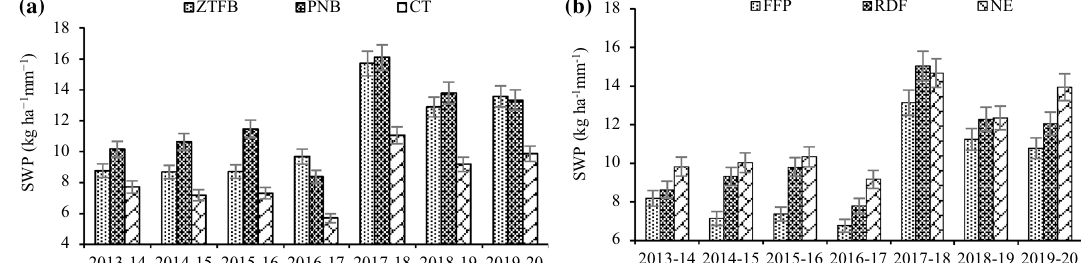
Figure 4. Seven years’ trends of SWP ( a , b ) in the CA-based CEP and nutrient management under the maize– chickpea rotation. The vertical bars indicate the LSD at p = Farm economics. The 7 years’ mean data indicated that the CT (US$ 639.9 ha −1 ) was the most expensive CEP, which was 15.3% and 16.9% costlier than the PNB (US$ 541.7 ha −1 ) and ZTFB (US$ 531.6 ha −1 ), respec- tively. Likewise, the RDF (US$ 582.7 ha −1 ) accounted for the highest cultivation cost, closely followed by the NE (US$ 576.7 ha −1 ), being 5% and 4.1% higher over the FFP (US$ 553.3 ha −1 ), respectively. In all the years, the PNB had the highest net returns, whereas, in 2016–17, the ZTFB accounted for the greater returns. However, the ZTFB and PNB did not differ for the system net returns, except during 2013–2014, 2016–2017, and 2018–2019. The PNB (US$ 1671.1 ha −1 ) and ZTFB (US$ 1565.9 ha −1 ) had generated 28.8% and 24% higher net returns than the CT (US$ 1189.8 ha −1 ), respectively. Similarly, the NE (US$ 1635.9 ha −1 ) and RDF (US$ 1528.4 ha −1 ) had 22.8% and 17.4% greater net returns than the FFP (US$ 1262.9 ha −1 ) (Table 3), respectively. Sustainable yield index (SYI). Among the CEP in maize, the PNB had the greater SYI, but being at par to the ZTFB, which was 15% and 13.2% greater than the CT. Further, SYI in maize was the highest under the NE, similar with RDF, being 29.1% and 25.6% greater than the FFP. In the case of chickpea, the SYI was highest under the PNB, which was 12.4% and 23.6% higher than the ZTFB and CT, respectively. The SYI in the NE and RDF were at par, being 8.9–12.8% greater than the FFP in chickpea (Table 1). System water productivity (SWP). During the first 3 years of the study, the PNB (10.1–11.5 kg ha-mm −1 )